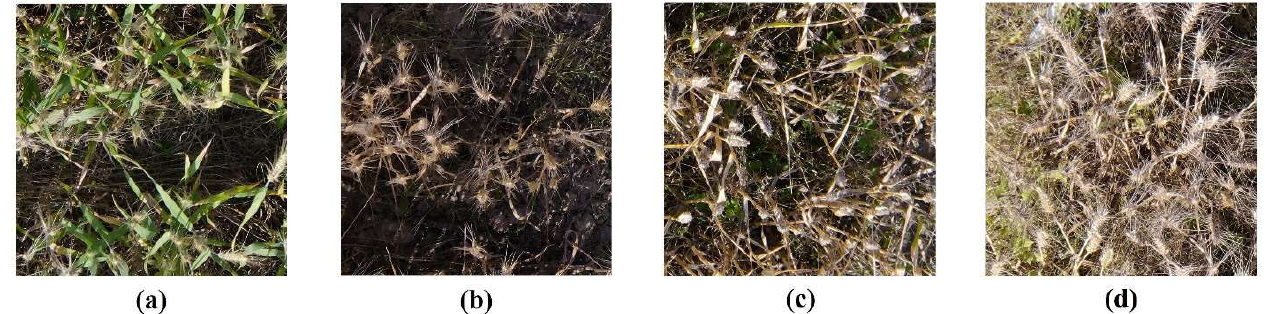
Figure 1. Common challenges faced in wheat head detection, ( a ) different growth stage, ( b ) brightness variation, ( c ) image blur, ( d ) overlapping.